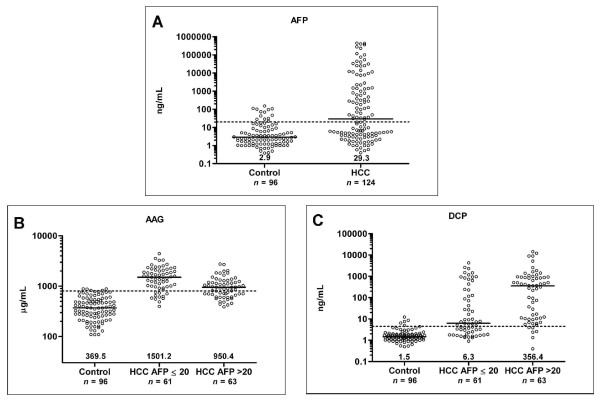
Scatter plots of plasma AFP, AAG, and DCP. Scatter plots of plasma (A) AFP, (B) AAG, and (C) DCP levels in control, AFP-low HCC, and AFP-high HCC. The black line indicates the median, for which the value is indicated on the bottom of the scatter plot. The dashed line indicates the cut-off value of each marker, 20 ng/mL for AFP, 800 μg/mL for AAG, and 4.5 ng/mL for DCP. In all markers, P < 0.0001 for control vs. either AFP-low HCC or AFP-high HCC.